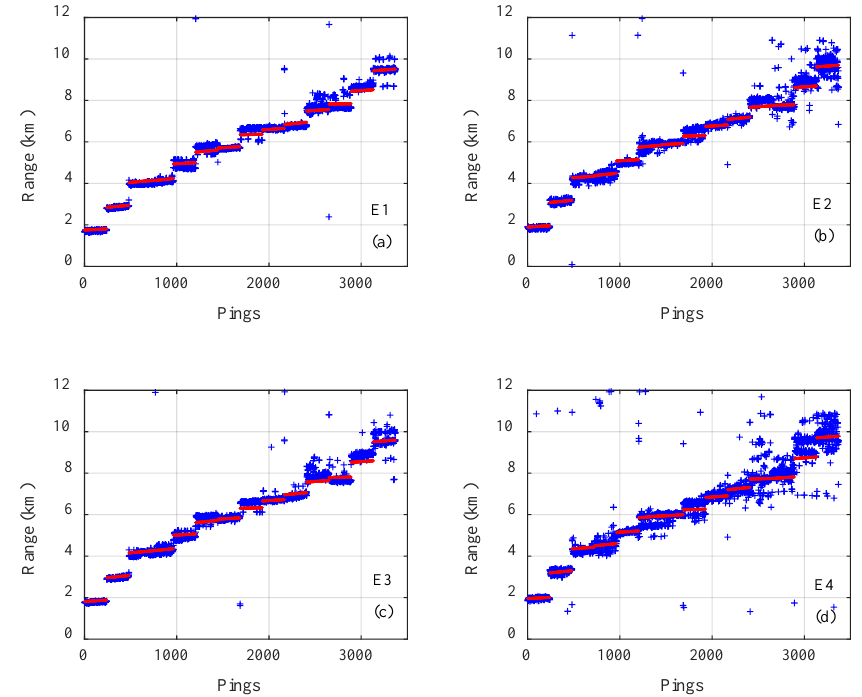
Figure 7. The true range (red) and the estimated range of the Gauss regression convolutional neural network (blue) for all 3371 samples on track 1 with emission energy of ( a ) E1, ( b ) E2, ( c ) E3, ( d ) E4.